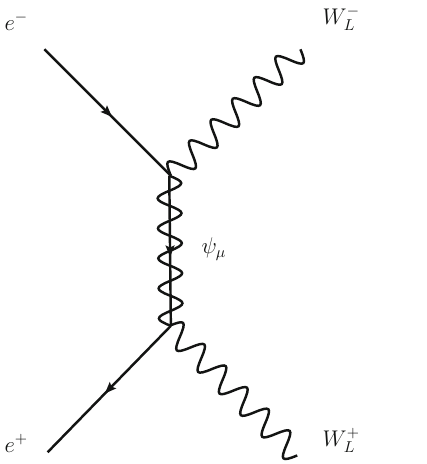
Fig. 6 The Feynman diagram for e + e − → W + ν ν → Z L L L Z L scattering has the same topology